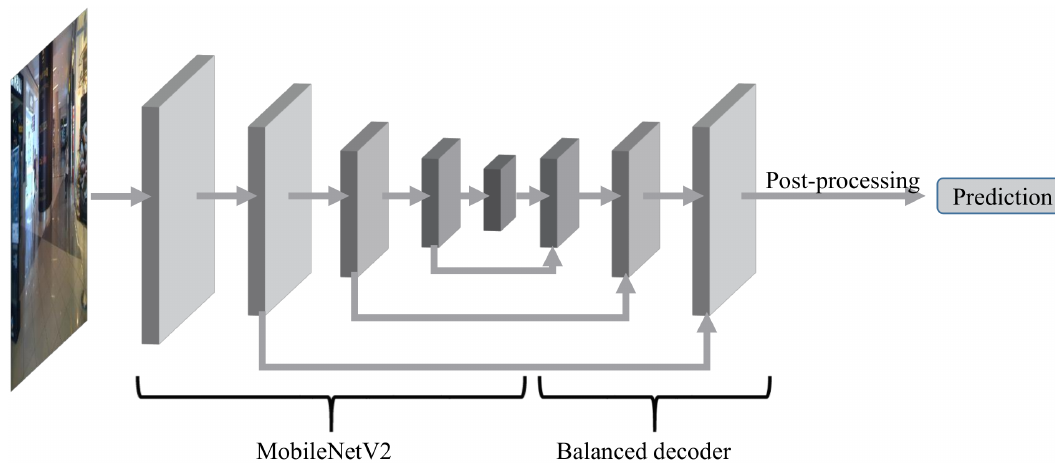
Figure 1. Overall flow of prediction. Images are passed to both MobileNetV2 and the balanced decoder, and post-processing generates the predicted